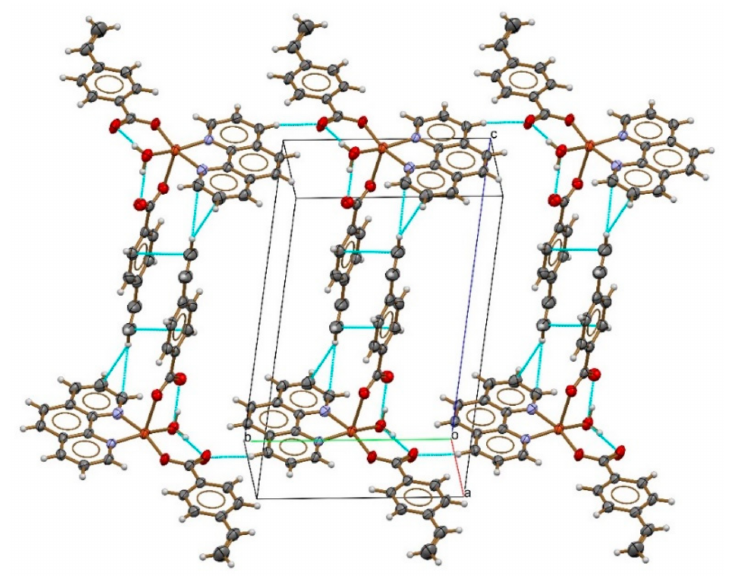
Figure 2. Crystal array of the functional monomer [Cuphen(VBA) 2 H 2 O], with a view along the a axis from the perspective of the plane formed by the b-c axes, emphasizing the H-bond and σ − π